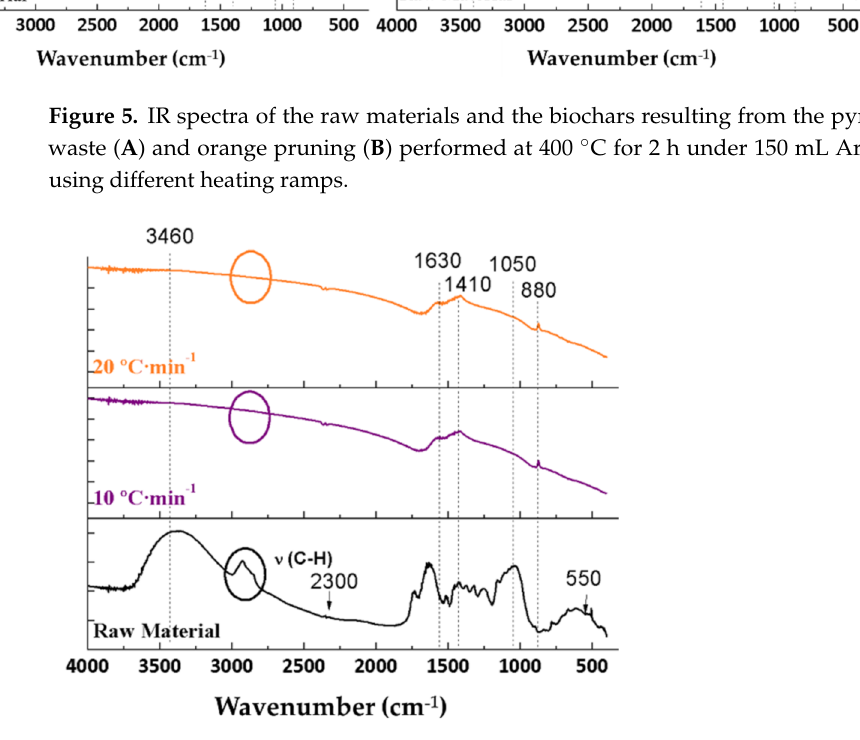
Figure 6. FTIR spectra of the raw material and the biochars resulting from the pyrolyses of orange pruning performed at 600 ◦ C for 2 h under 150 mL Ar · min − 1 flow rate using different heating ramps. All bands marked in Figures 5 and 6 and described in Sections 3.3.1 and 3.3.2 were not affected by varying the flow rate. These bands included the bands at 3460 and 1630 cm − 1 (water), at 2900 cm − 1 (C-H), at 2300 cm − 1 (CO 2 ), at 1730 cm − 1 (C=O), at 1410 cm − 1 (carboxylic acid), at 1060 cm − 1 (C-O), at 880 cm − 1 (aromatic), and at 550 cm − 1